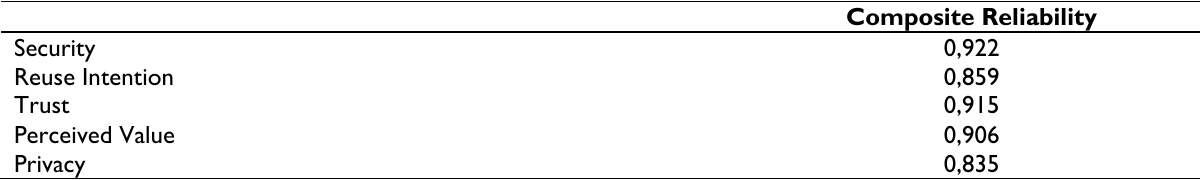
Table 4. Composite Reliability